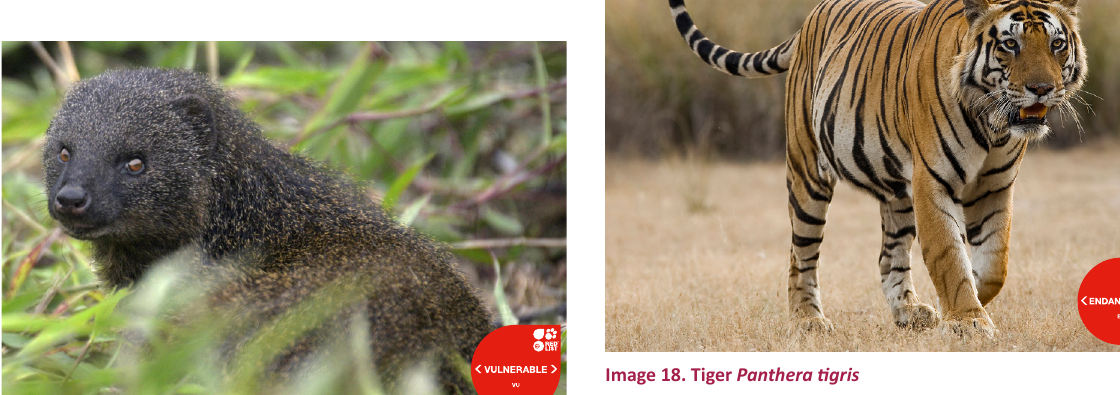
Image 14. Indian Pangolin Manis crassicaudata